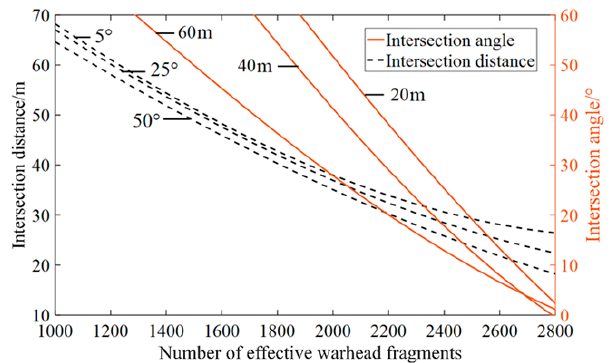
Figure 4. Variation curve of the number of warhead fragments hitting the target under different intersection angles and intersection distances.